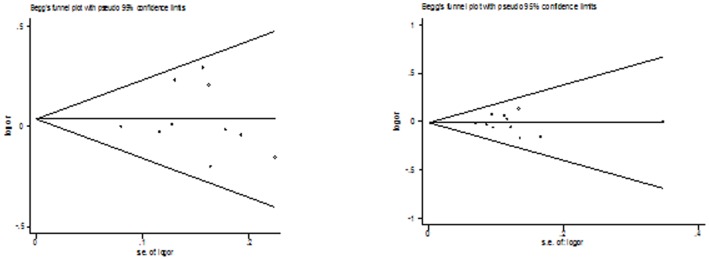
Begg's funnel plot of the meta-analysis of colorectal cancer risk and CYP1B1 Leu432Val polymorphism (homozygote model and dominant model).